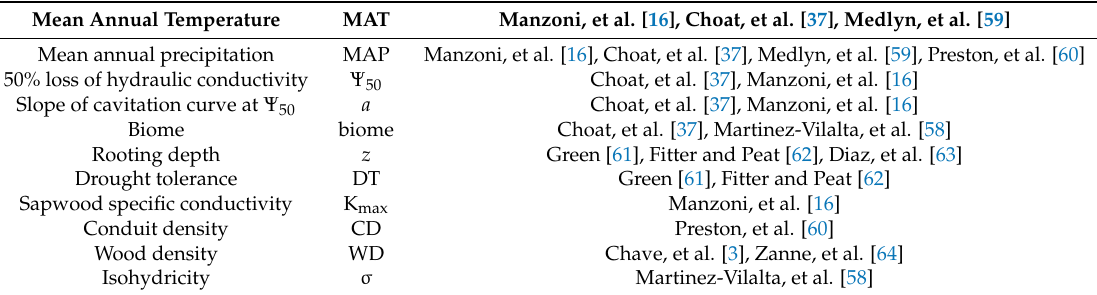
Table 1. Variables used in this study and databases from which they were